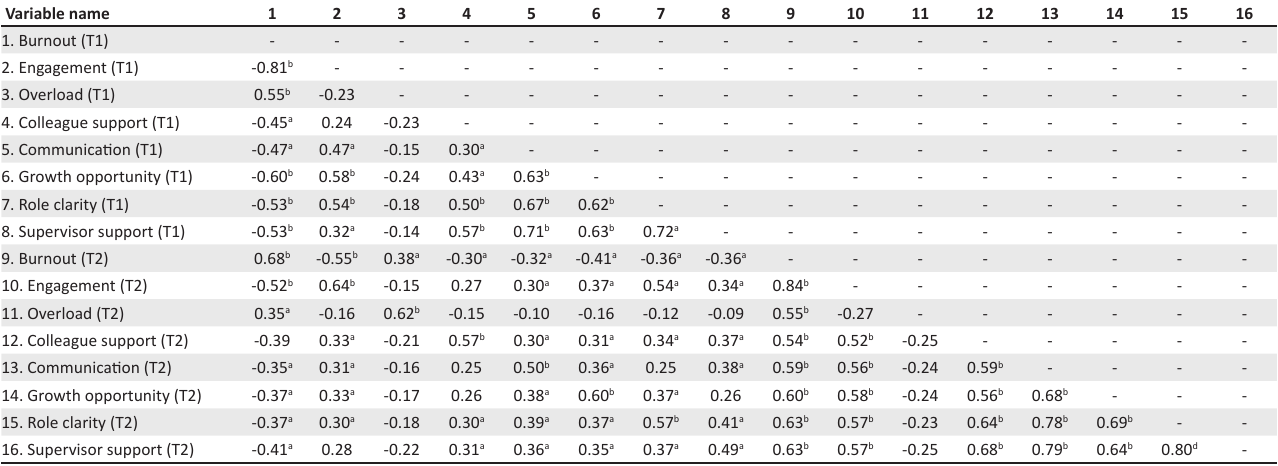
TABLE 5 : Correlation matrix ( r ) of the latent variables ( n =